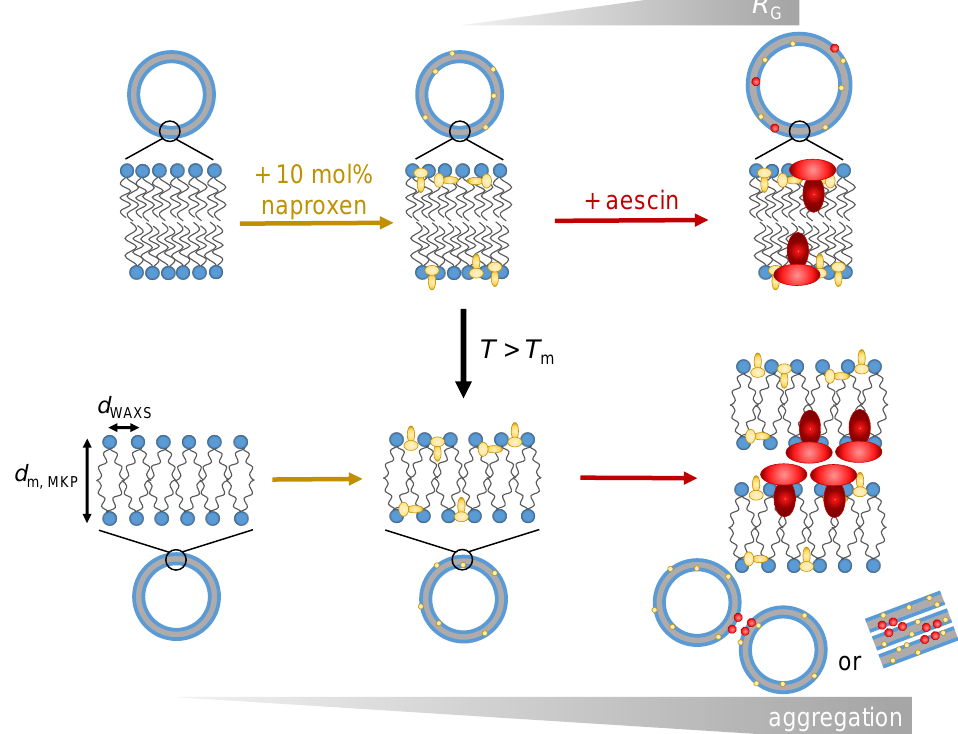
Figure 12. Schematic illustration of the proposed interplay of the drug naproxen and the saponin aescin with DMPC vesicles as model membranes. The figure displays the intercalation of both substances into the membranes and the aescin-induced formation of